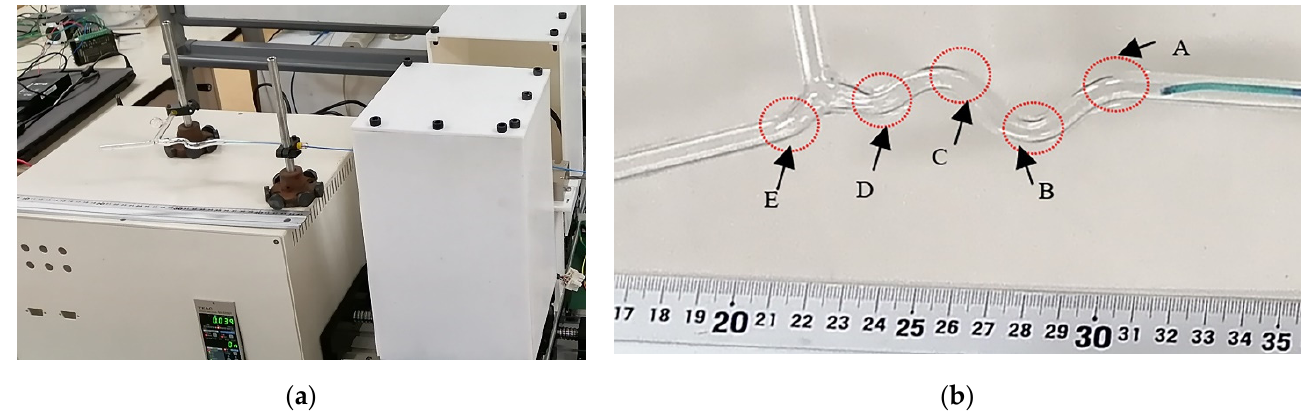
Figure 16. ( a ) Glass tube test design; ( b ) inflection points (A, B, C, D, E) in the glass